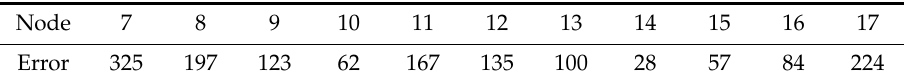
Table 3. The error of hidden nodes.